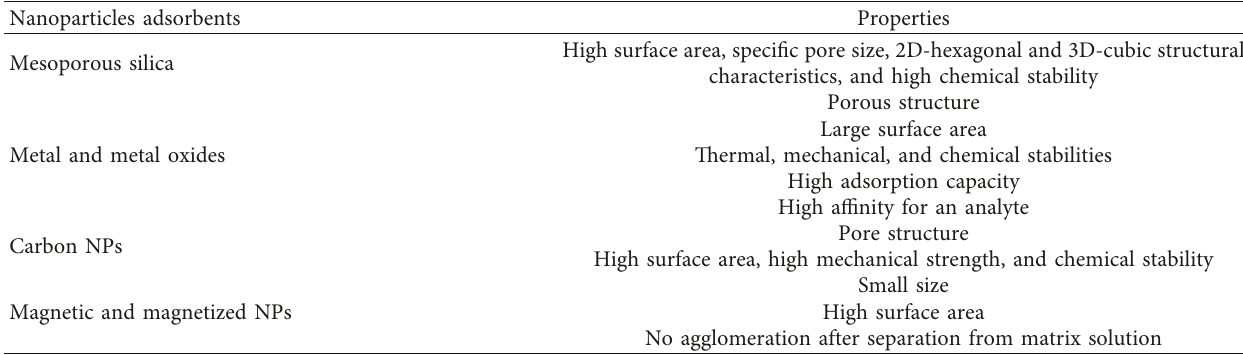
Table 8: Some properties of nanoparticles adsorbents for PAH